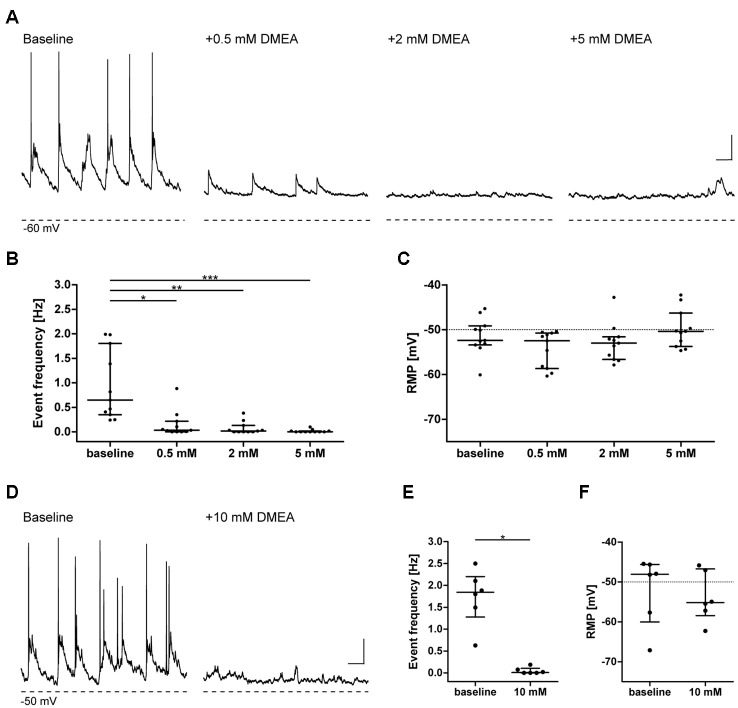
Dimethylethanolamine (DMEA) decreases spontaneous neuronal activity in neuronal cultures in a concentration-dependent manner. Activity of cultured hippocampal neurons (DIV 13–16) was investigated in current-clamp mode in the absence or presence of DMEA. During baseline conditions, all neurons displayed excitatory synaptic events with associated action potentials (APs) at a frequency of ~1 Hz. Both AP, as well as large amplitude synaptic event frequency, decreased with increasing DMEA concentration to reach a full block with 5 mM DMEA. (A,D) Exemplary recordings in neurons with application of 0.0, 0.5, 2.0 and 5.0 mM DMEA (A) or 10 mM DMEA (D); note that due to experimental setup we could not perform repeated measurement in one cell including all concentrations and present the results here separately; Dashed lines below recordings indicate resting membrane potential (RMP, in mV) of cells. (B,E) DMEA significantly decreases event frequency in a concentration-dependent manner. (C,F) Application of DMEA does not affect RMP. All data are shown as scatter plots with median and interquartile range. Asterisks mark significant differences as assessed by Friedman test and post hoc by Dunnett’s multiple comparison of groups (B,C) or by Wilcoxon signed-rank test (E,F; *p < 0.05, **p < 0.01, ***p < 0.001). Scale bar: 10 mV, 0.5 s.